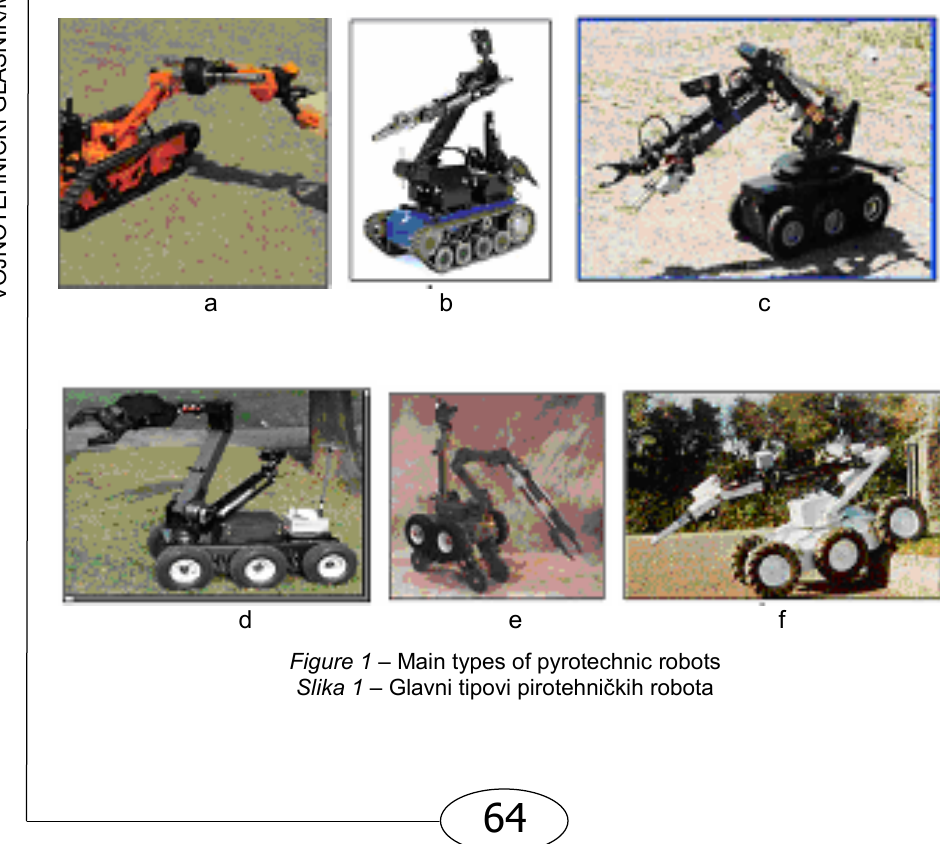
Figure 1 – Main types of pyrotechnic